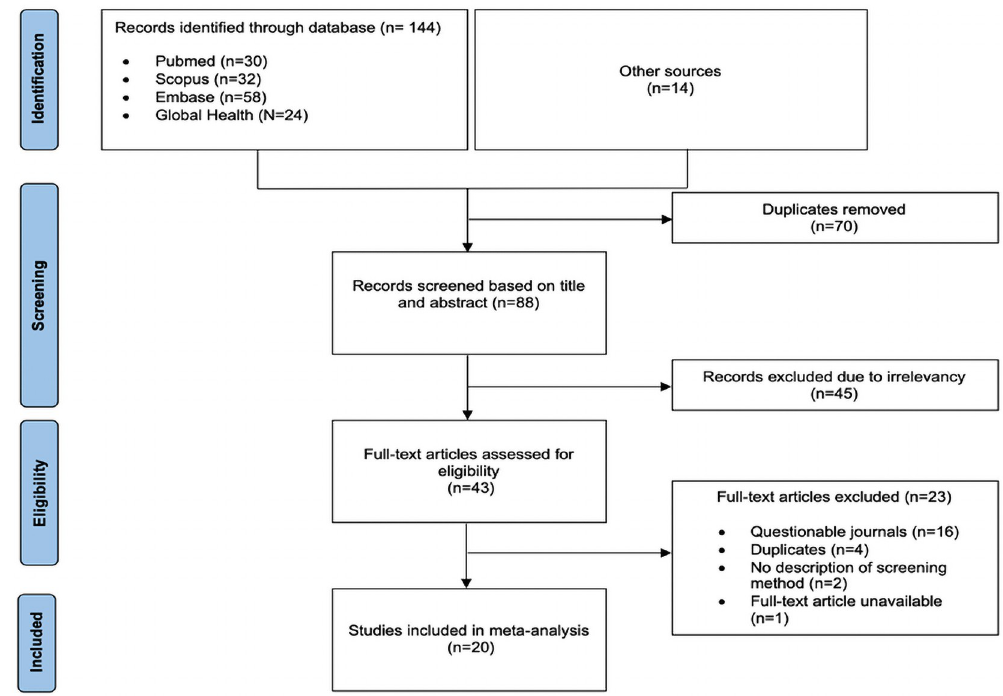
Fig 1. PRISMA flow diagram of the process of study identification and